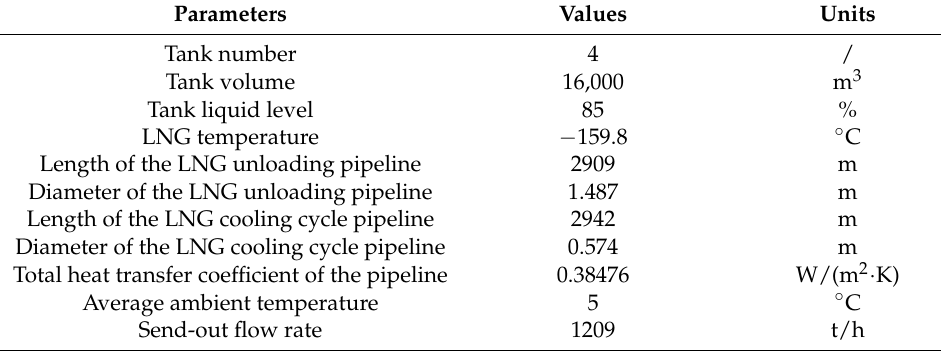
Figure 2. Structure of the original condition. Table 1. Environmental variables and related process parameters of optimization.